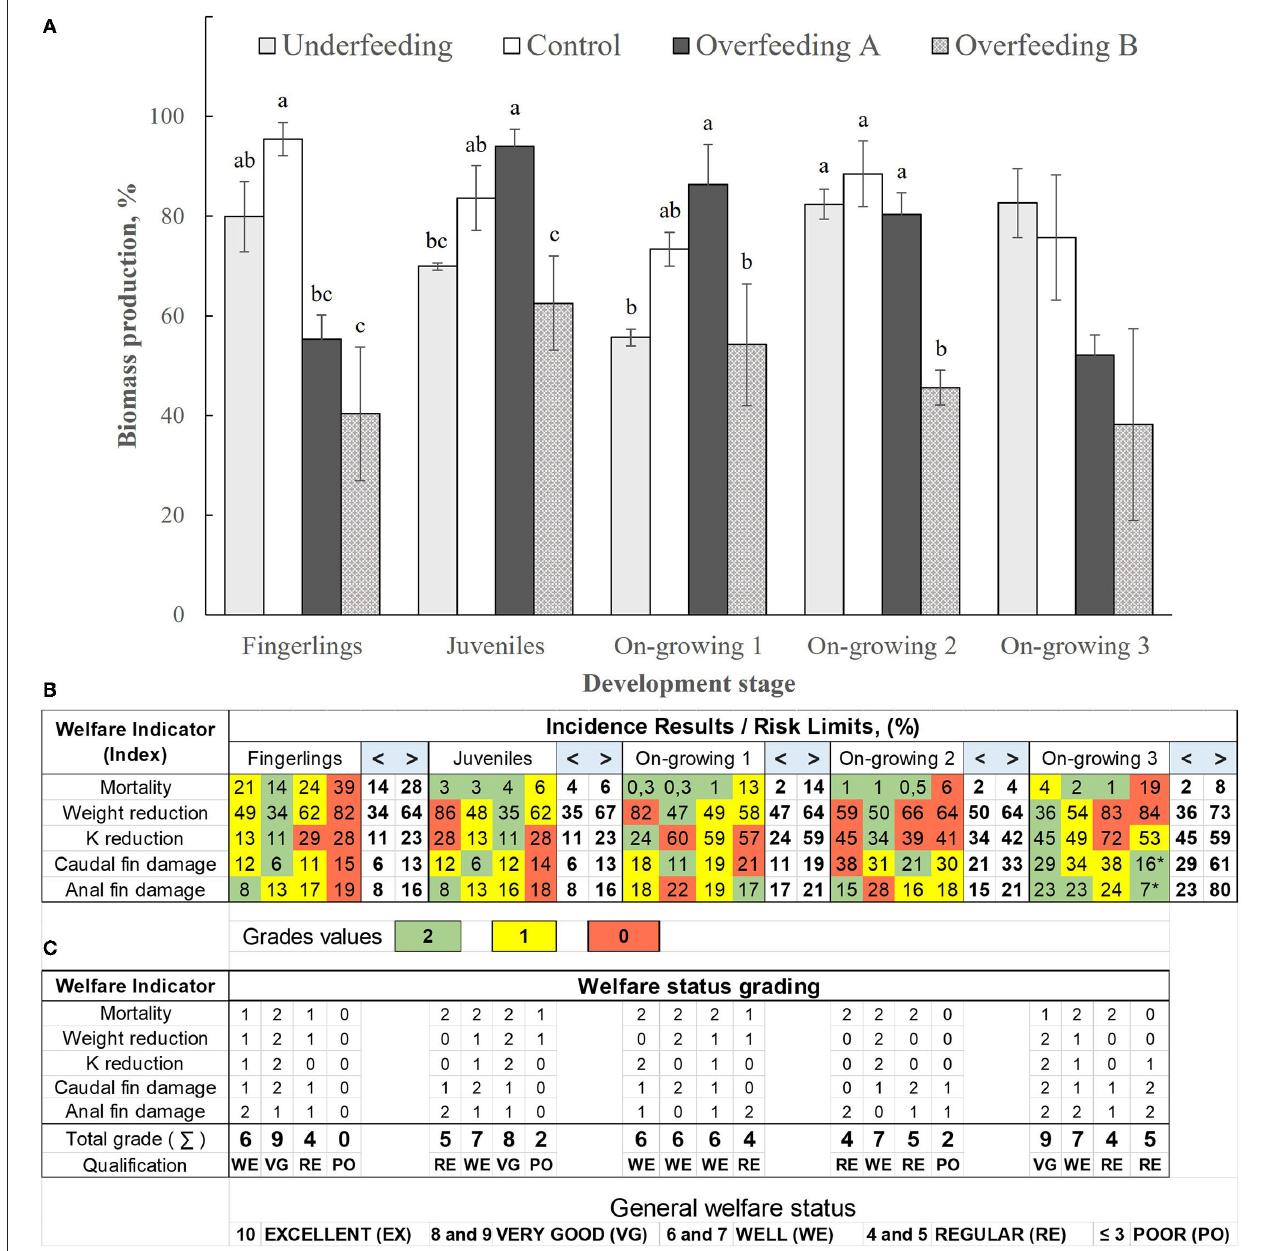
FIGURE 1 | (A) Biomass production per pond per treatment (means ± SE) in the 5 experiments carried out according to the treatments: underfeeding (80%), control (100%), overfeeding A (120%), and overfeeding B (140%). (B) Each cell in color is the value resulting from the % I Tx of the epidemiological analysis (integer) according to the welfare indicator of each treatment (from Tables 4 – 8 ). White cells are risk limits (%) for welfare indicators in relation to the individuals present in the culture pond of each treatment (from Table 3 ; < and > ). (C) The application of the proposed epidemiological traffic light and the qualification of the welfare state by treatment according to the evaluated indicators. Color traffic lights are categorized as Green (2 points), Yellow (1 point), and Red (0 points). The value of the evaluated indicators added (summative) to obtain a comprehensive/overall qualification (fingerlings to on growing 3) of the welfare state according: Excellent (EX: 10 points), Very Good (VG: 8 and 9 points), Well (WE: 6 and 7 points), Regular (RE: 4 and 5 points) and Poor (PO: ≤ 3 points). *False positive, as an effect of the high mortality occurred in said treatment. Means ± SE.